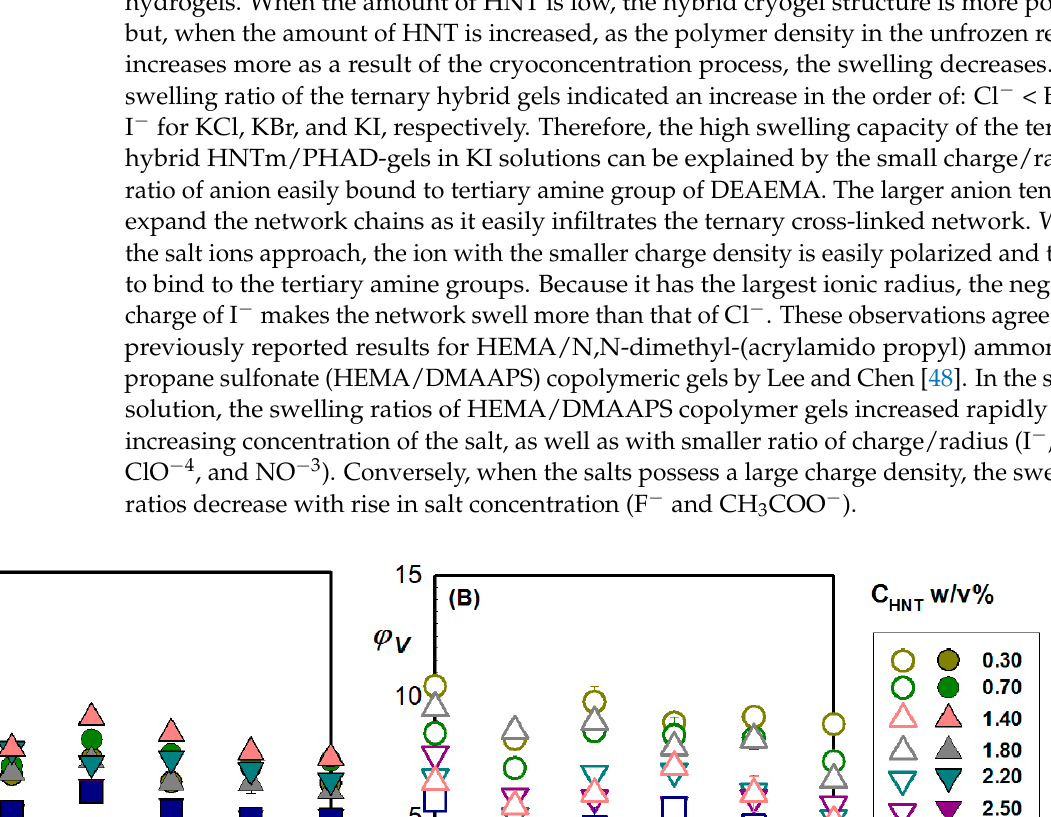
Figure 13. The equilibrium volume swelling ratio V of the ionic strength of aqueous salt solutions of KCl.